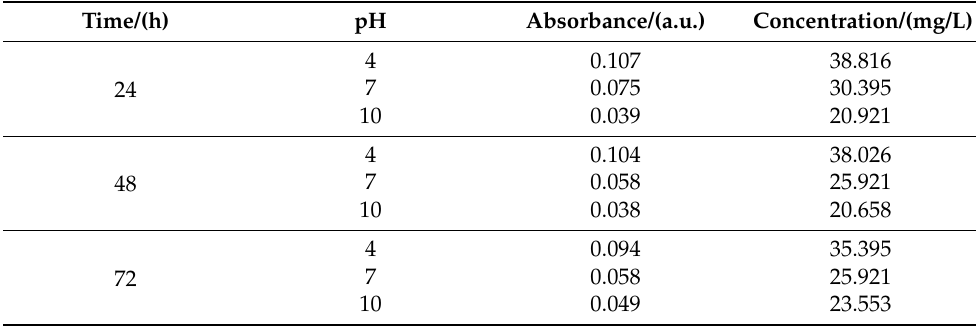
Figure 5. Release curves of SLS from the CaCO 3 micro-containers at different pH values: ( a ) 24 h, ( b ) 48 h, and ( c ) 72 h. Table 1. Time dependent release of sodium lignosulfonate (SLS) from the CaCO 3 micro-containers under different pH values of the aqueous